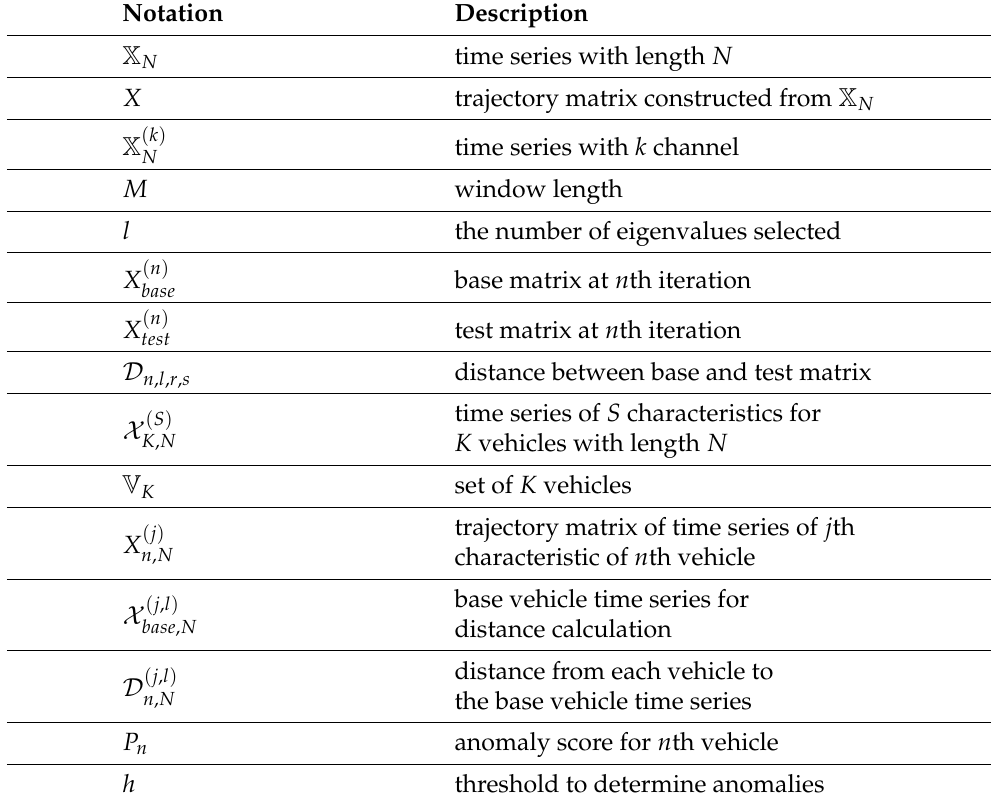
Table 1. Notations used in